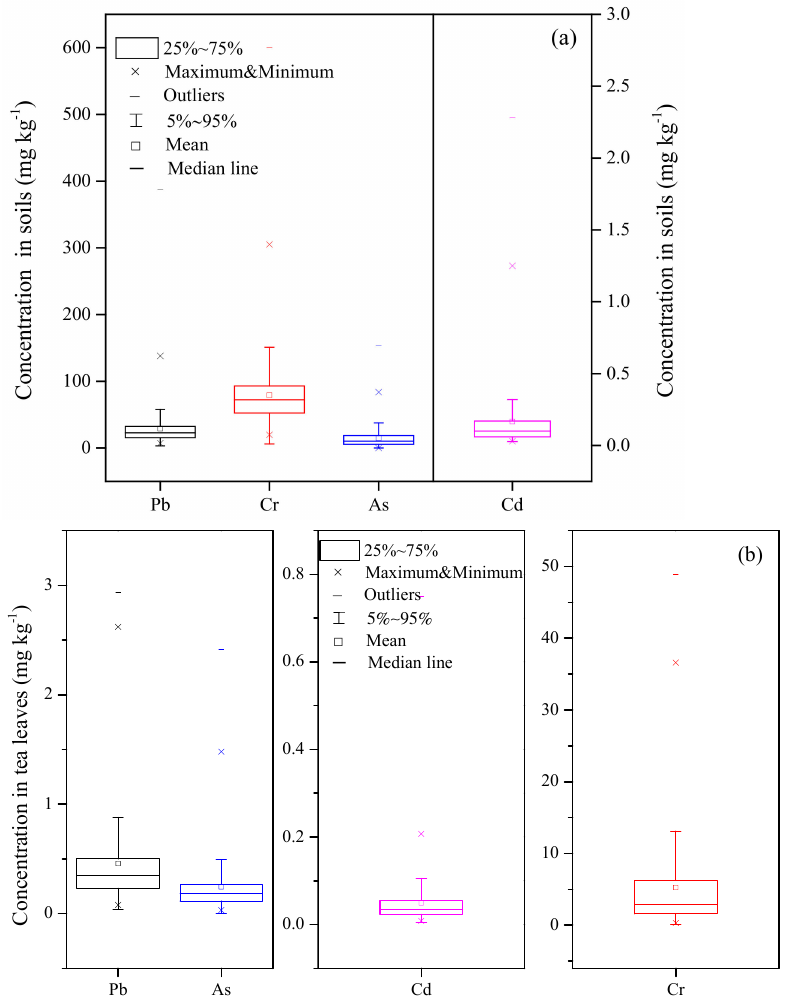
Figure 2. Contents of Pb, Cr, As, and Cd in soil ( a ) and tea leaves ( b ) samples. The standard values in China (NY/T853-2004) for Pb, Cr, As, and Cd are 250, 150, 40, and 0.3 mg kg − 1 for pH ≤ 6.5 soil, and 300, 200, 30, and 0.4 mg kg − 1 for pH > 6.5 soil. The residue limits values of tea leaves (NY695–2003 and GB2762–2017) for Pb, Cr, As, and Cd are 5, 5, 2, and 1 mg kg − 1 , respectively.